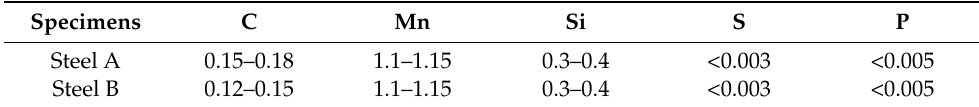
Table 1. Chemical compositions of the two tested steel samples.